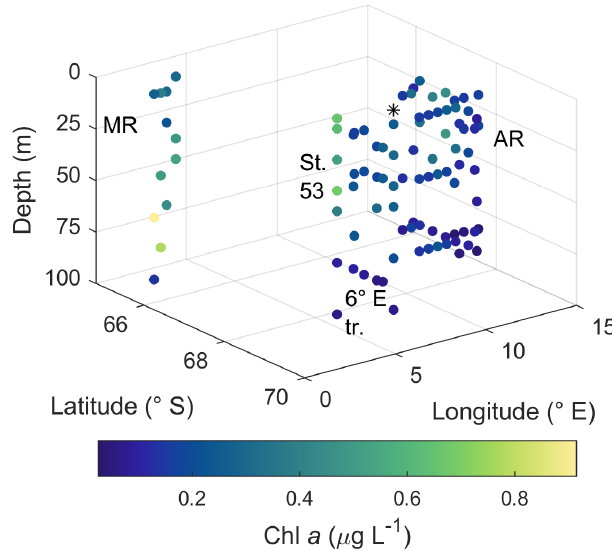
Figure 3. Horizontal and vertical distribution of phytoplankton biomass expressed as Chl a concentration. MR: Maud Rise, St. 53: station 53, AR: Astrid Ridge, 6 ◦ E tr.: 6 ◦ E transect. Station 54 is marked with a black